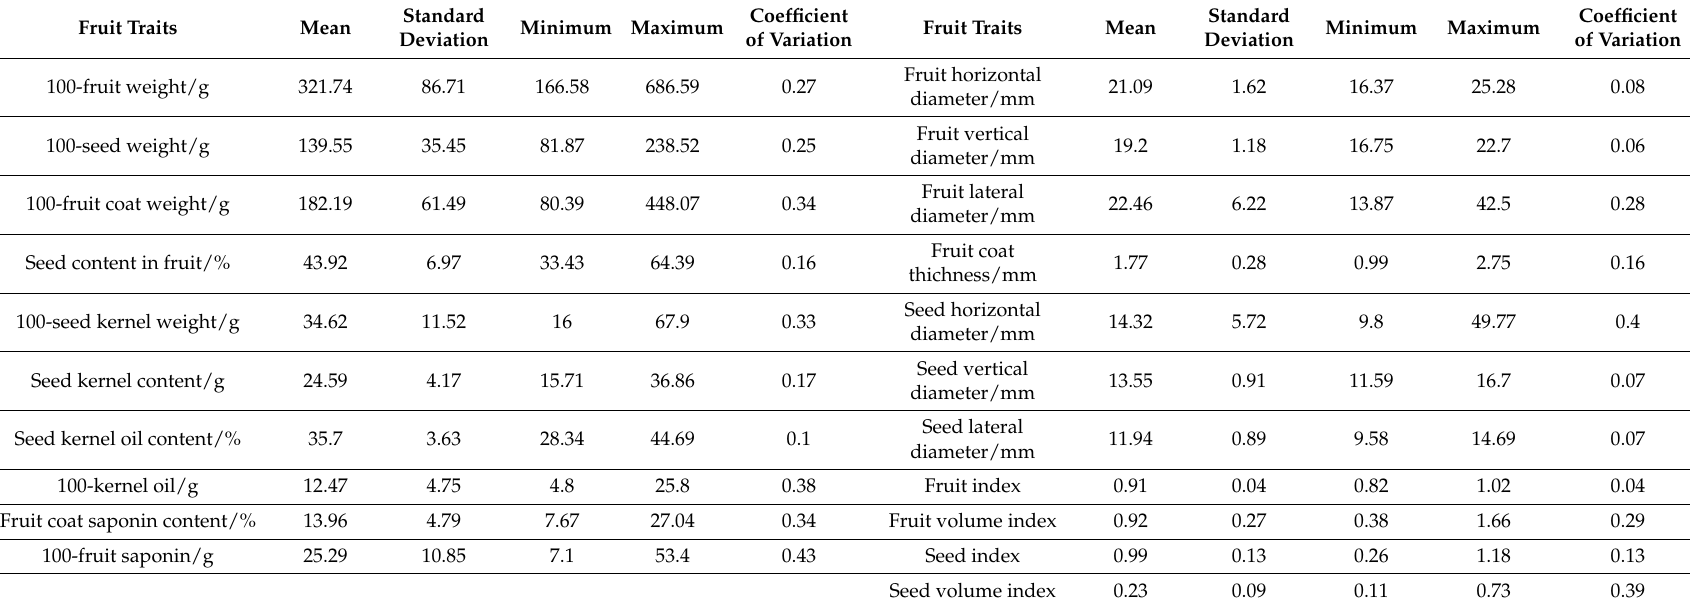
Table 2. Descriptive statistics of seed and fruit traits of Sapindus mukorossi